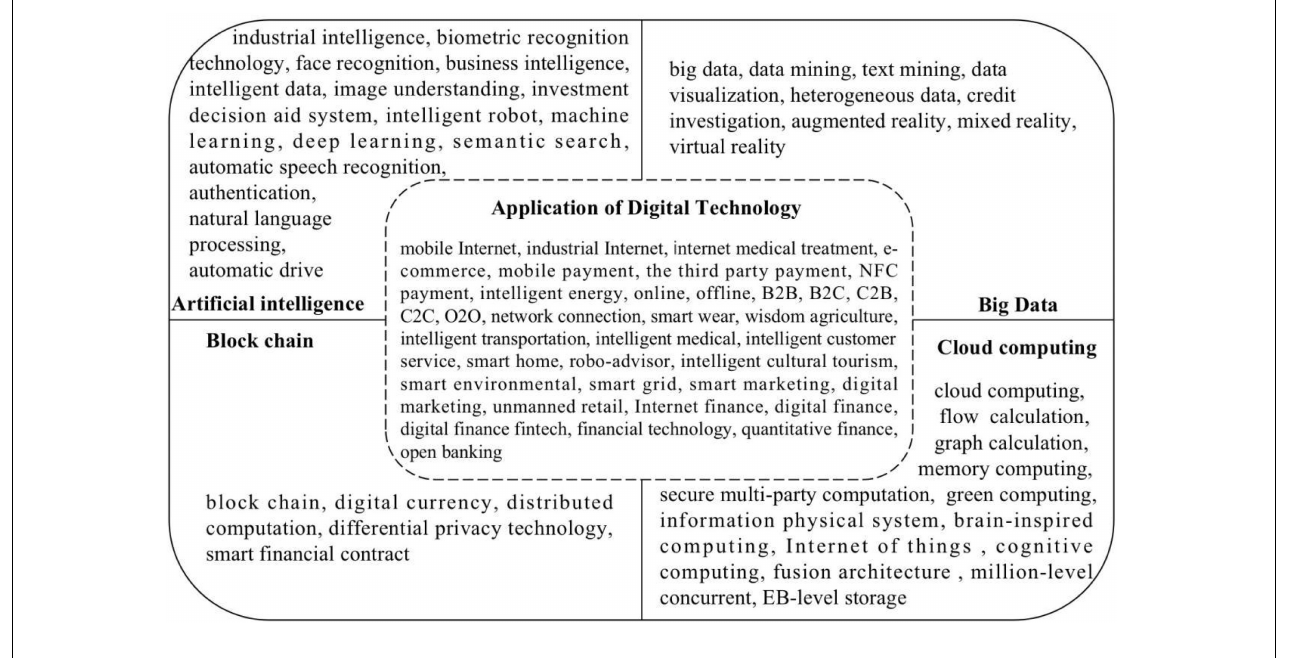
FIGURE 1 | The keyword list of digital transformation. TABLE 1 | Descriptive statistics and Pearson correlation coefficients ( N =